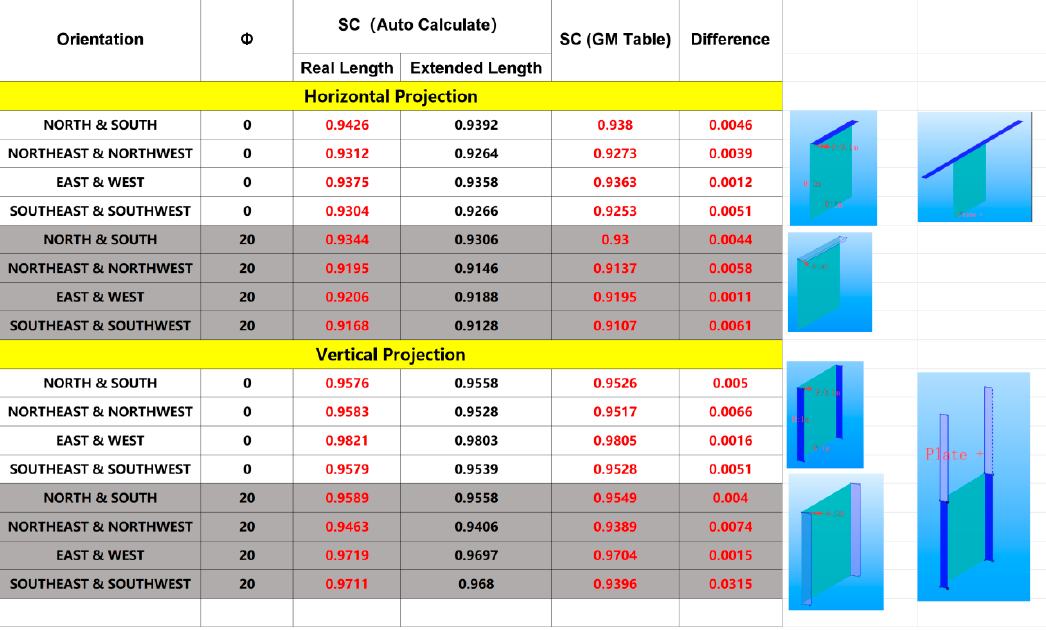
Figure 18. SC2 comparison calculation by using the proposed digital method and the traditional method.